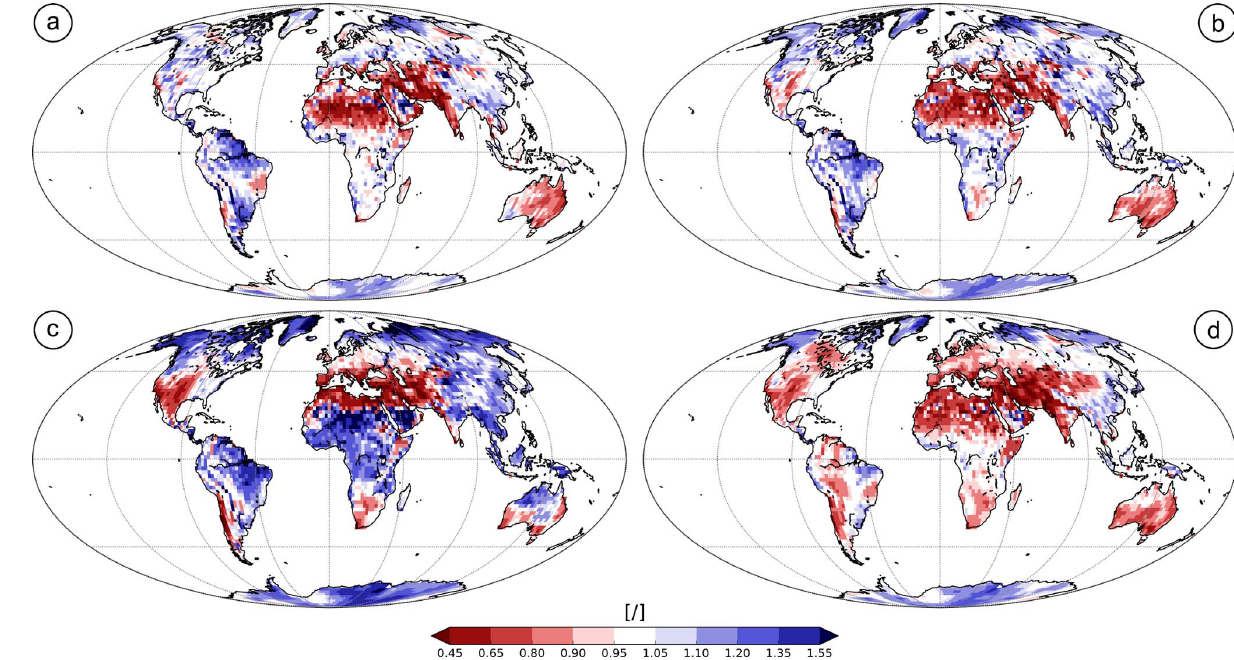
Figure 4. Changes in water availability. For IR26, (a) the water available for crops (precipitation + irrigation) in 2100 relative to the present day (REF). (b) Same as (a) but for IR45. (c) Same as (a) but for IR85. (d) Same as (a) but for RF45. Future water availability is reduced in catchments in which precipitation declines, e.g., in the US, the Middle East and southern Europe, but it can also be reduced despite increases in precipitation. In India, for example, irrigation is reduced substantially when rates are adjusted to a sustainable level and for IR26 (a) and IR45 (b) there is a predominant decrease in water availability despite increases in monsoon precipitation. For IR85 the precipitation increase is so strong that in 2100 the water availability exceeds that of the year 2005 (c) . Note that at long rivers, the available water near the estuary can also be reduced by increasing withdrawals by upstream riparian states, e.g., at the Nile, as present-day water rights agreements are not represented in the model. The increase in water availability occurs mainly in South America and sub-Saharan Africa, while between 15 and 45 ◦ N amounts predominantly decline. Without irrigation, the water availability is reduced globally, with a few exceptions mostly in high northern latitudes and Southeast Asia (d)